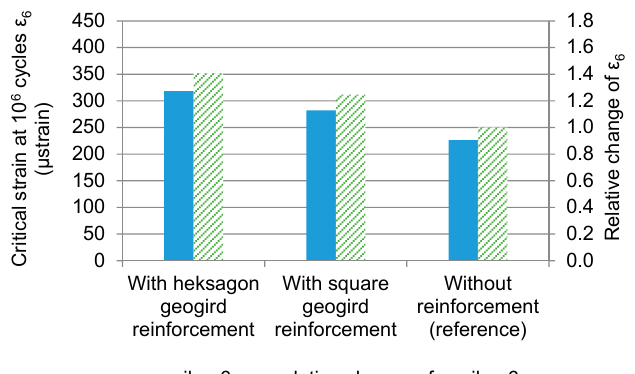
Figure 13. Comparison of critical strain ε 6 and its relative change after introduction of reinforce- ment.